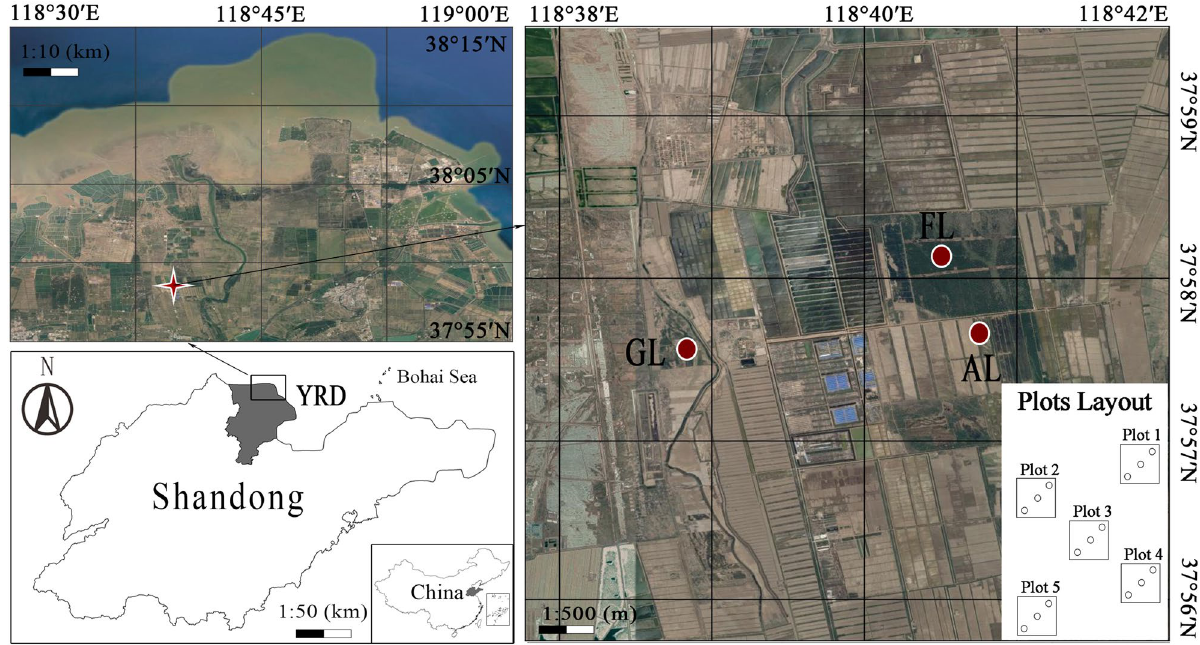
Figure 6. The location of the study area in the Yellow River Delta of Shandong Province and the layout of the study plots (not to scale); this map was created using the software of Photoshop CS6 and Bigemap 14.1 https :// www.bigem